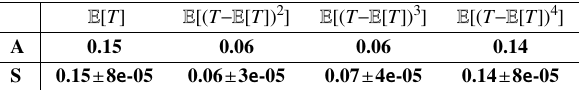
Table 5: Class 1 response time moments from GRID dataset.